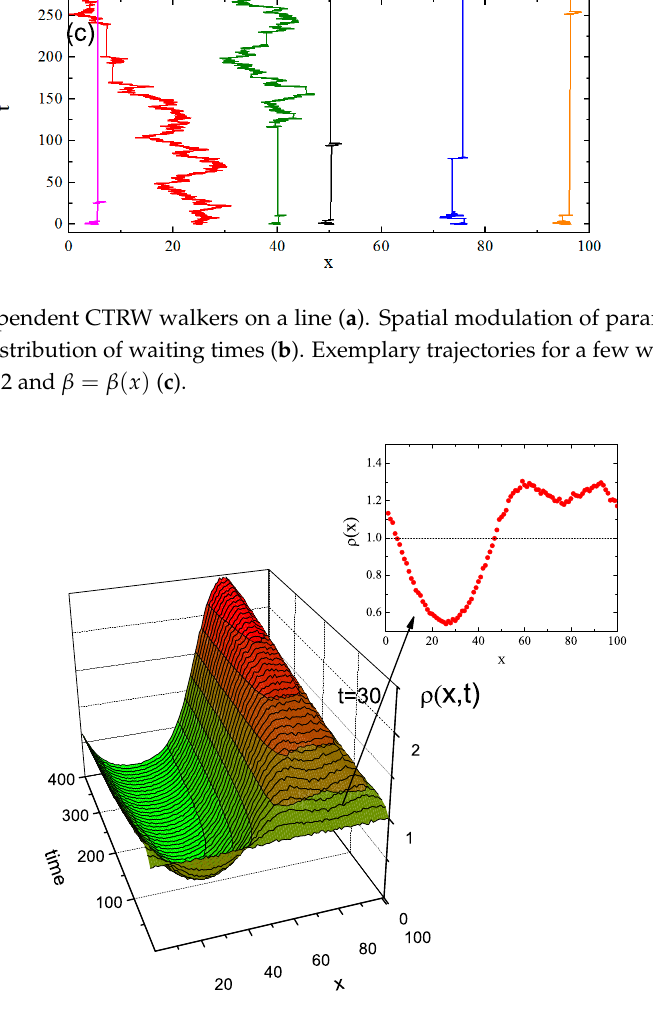
Figure 13. Temporal evolution of density ρ ( x , t ) of system of walkers performing CTRW with α = 2 and β = β ( x ) . See text for more